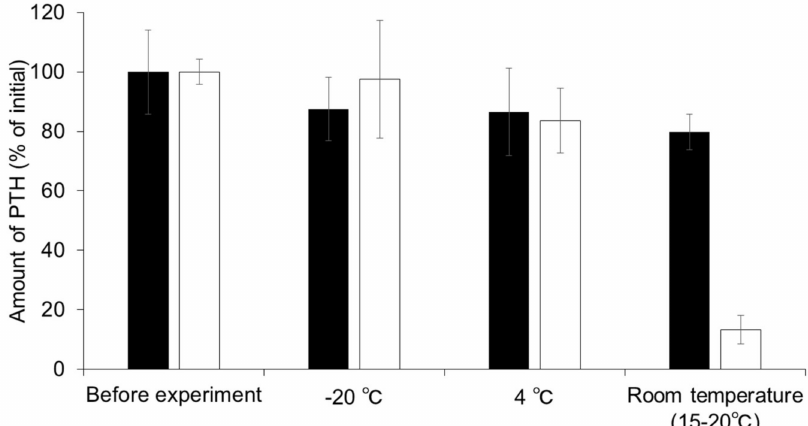
Figure 2. Stability of human parathyroid hormone (1-34) (PTH) in microneedle arrays (MNs) and PTH solution stored at − 20, 4, and 15–20 ◦ C for one month. Keys: ( (cid:4) ) PTH-loaded MNs and ( (cid:3) ) PTH solution. Results are expressed as the means ± standard deviation (SD) of three